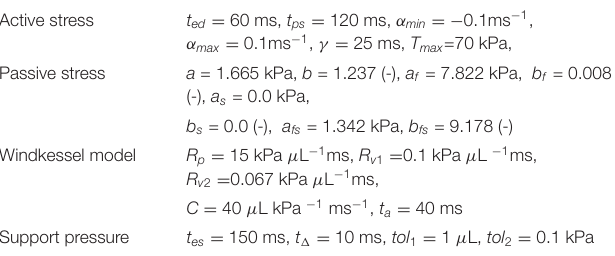
TABLE A1 | Material parameters used in the numerical